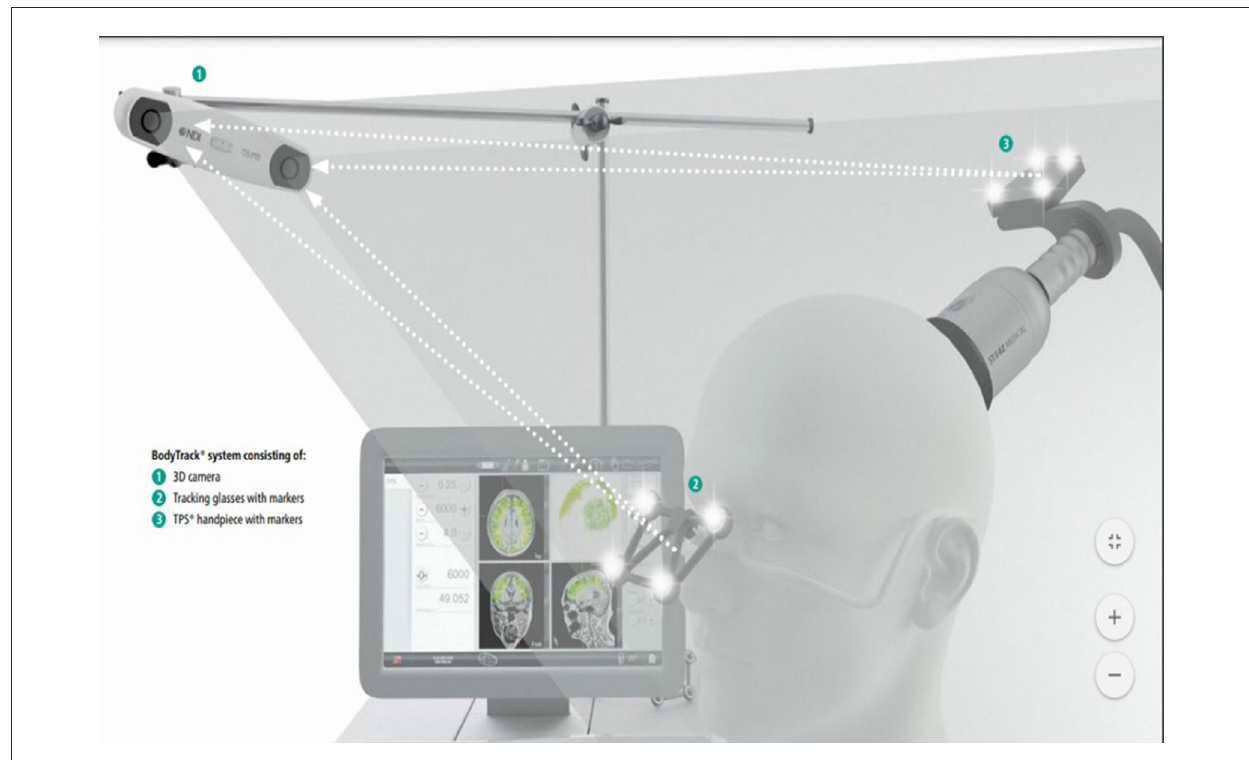
FIGURE2 Transcranial pulse stimulation (TPS)